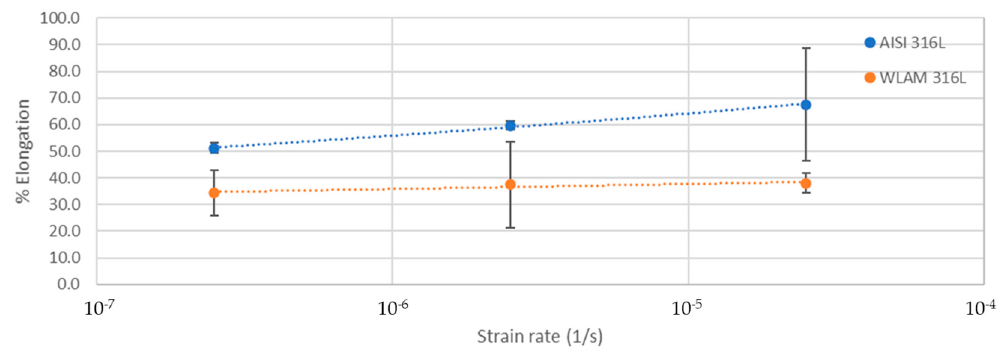
Figure 9. Elongation vs. strain rate of the WLAM samples and the counterpart AISI 316L alloy.